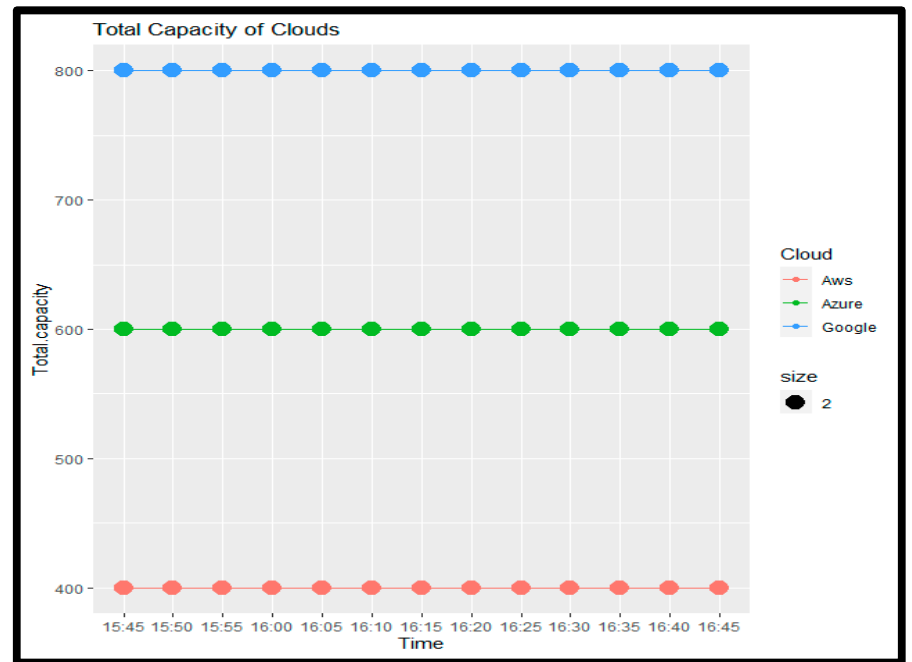
Figure 3. Random selections of V.M machine using algorithm.